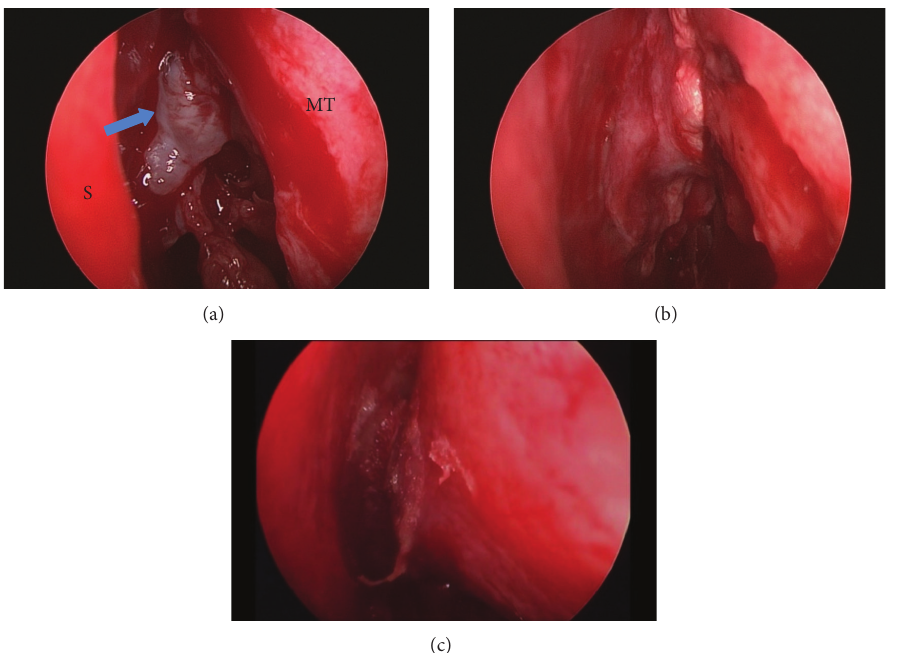
Figure 1: (a) Transethmoidal meningoencephalocele of the left cribriform plate (blue arrow) between the nasal septum (S) and the middle turbinate (MT). (b) Temporalis fascia applied in an overlay technique. (c) Fibrin glue